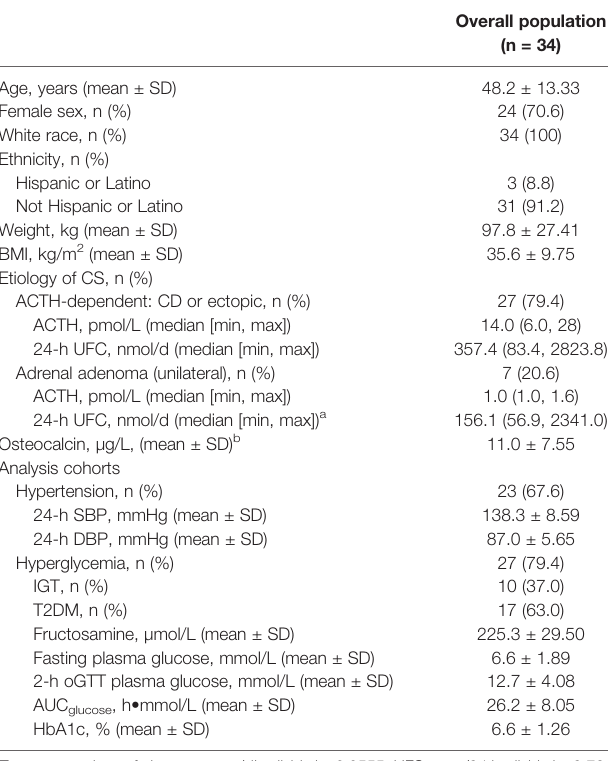
TABLE 1 | Demographic and clinical characteristics at baseline (ef fi cacy population, n = 34).